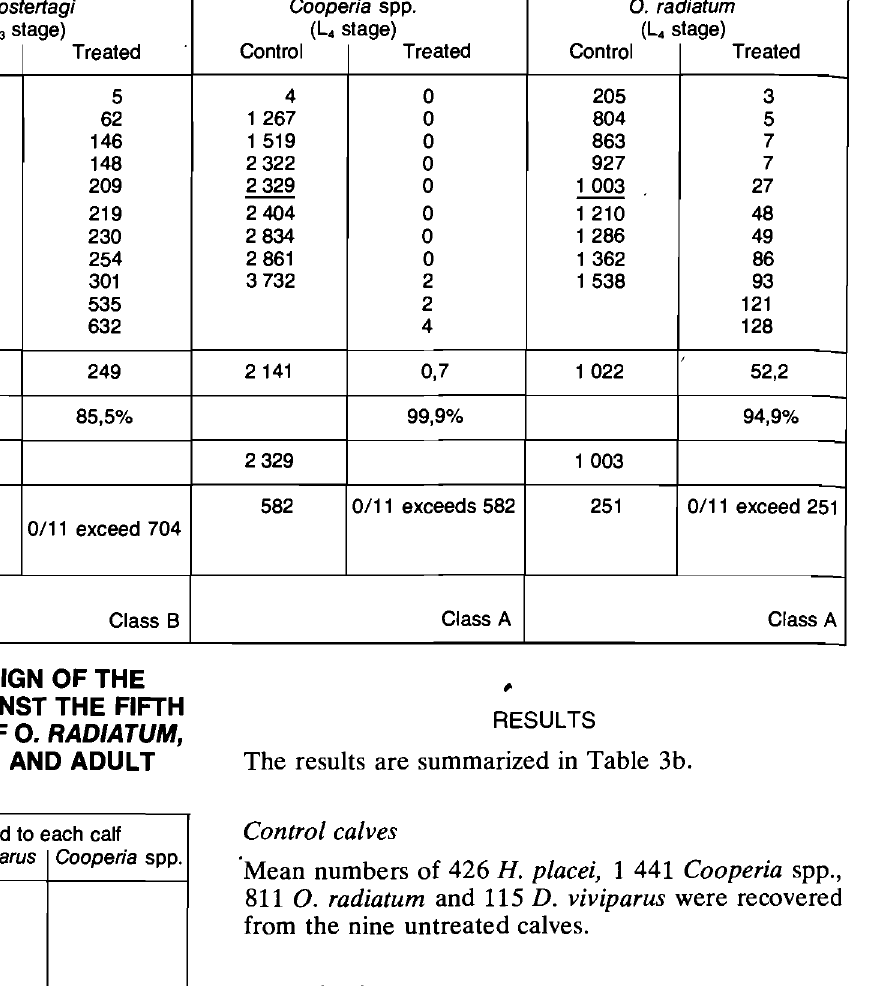
Table 3a: EXPERIMENT 3. DESIGN OF THE EXPERIMENT ON ACTIVITY AGAINST THE FIFTH LARVAL AND ADULT STAGES OF O.